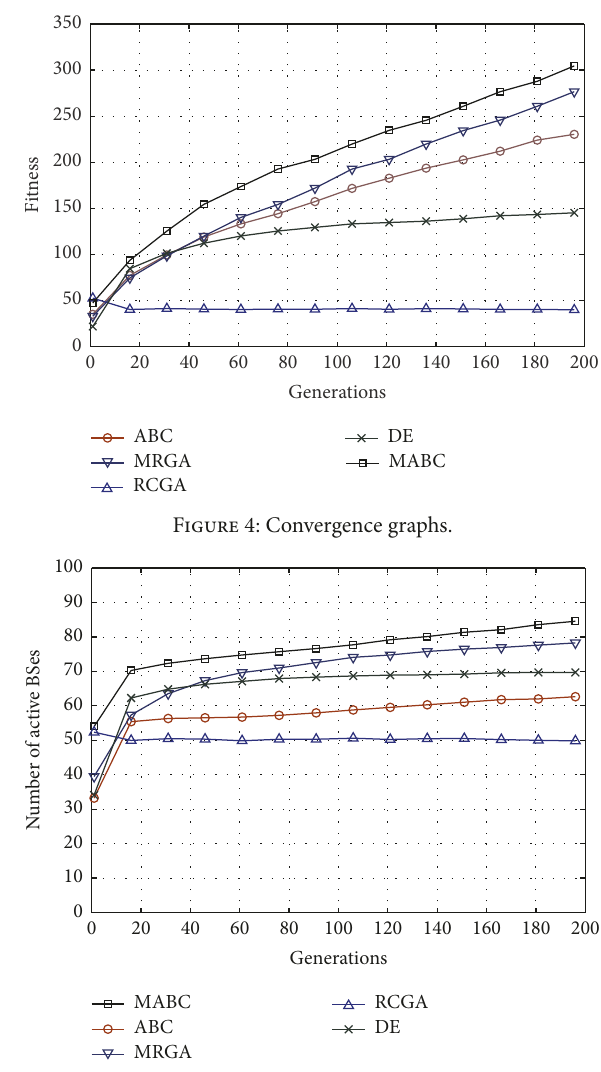
Figure 5: The number of active base stations towards a